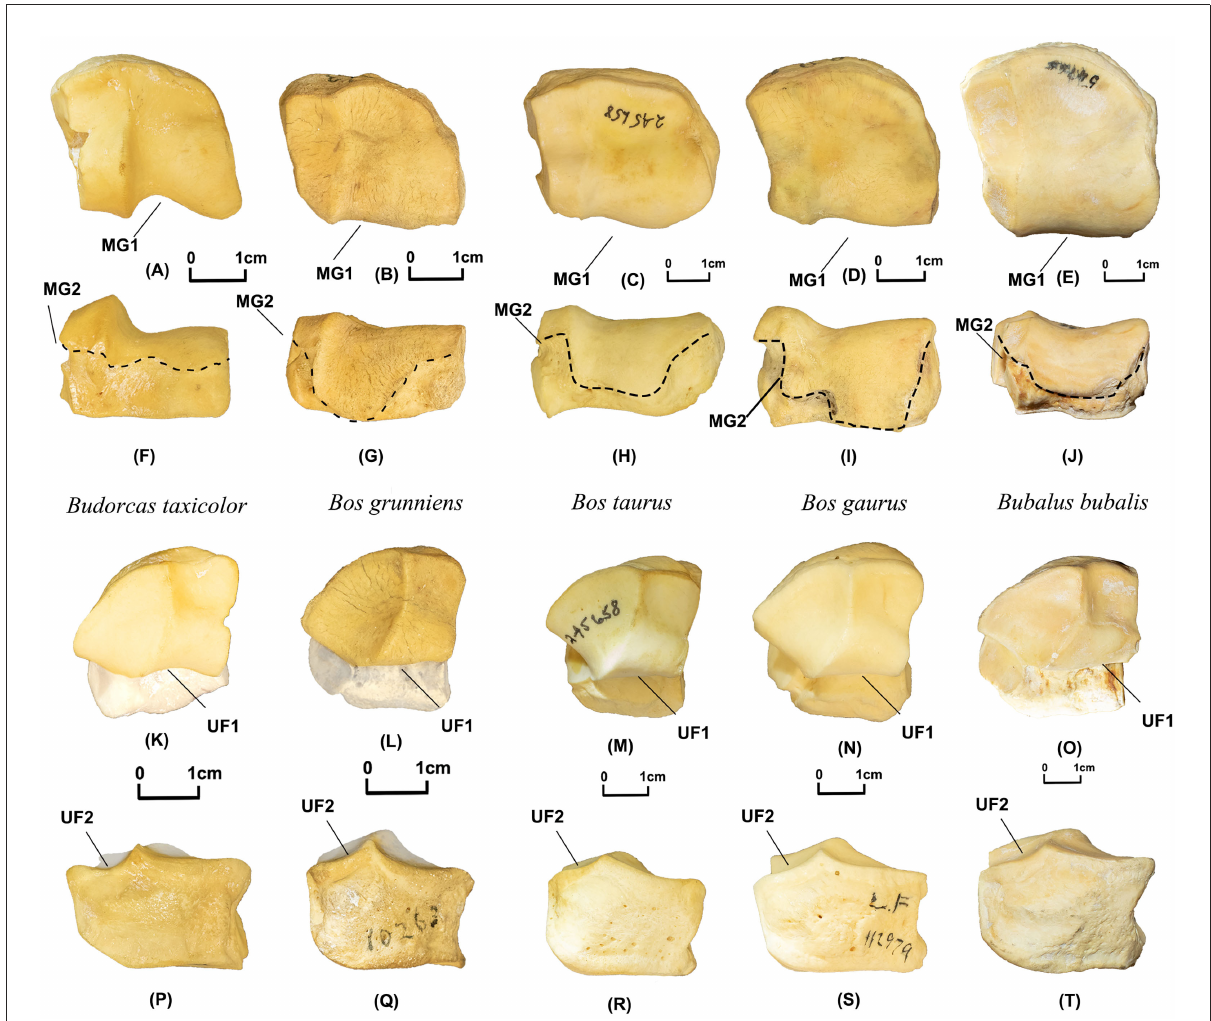
FIGURE5 Magnum and unciform of takins and Bovini. Proximal view of magnum: (A) Budorcas taxicolor (AMNH − 57017), (B) Bos grunniens (AMNH–MO − 10263). (C) Bos taurus (AMNH − 245658). (D) Bos gaurus (AMNH–M − 54469). (E) Bubalus bubalis (AMNH–M − 54765). Posterior view of magnum: (F) Budorcas taxicolor (AMNH − 57017), (G) Bos grunniens (AMNH–MO − 10263). (H) Bos taurus (AMNH − 245658). (I) Bos gaurus (AMNH–M − 54469). (J) Bubalus bubalis (AMNH–M − 54765). Proximal view of unciform: (K) Budorcas taxicolor (AMNH − 57017), (L) Bos grunniens (AMNH–MO − 10263). (M) Bos taurus (AMNH − 245658). (N) Bos gaurus (AMNH–M − 112979). (O) Bubalus bubalis (AMNH–M − 54765). Posterior view of unciform: (P) Budorcas taxicolor (AMNH − 57017), (Q) Bos grunniens (AMNH–MO − 10263). (R) Bos taurus (AMNH − 245658).